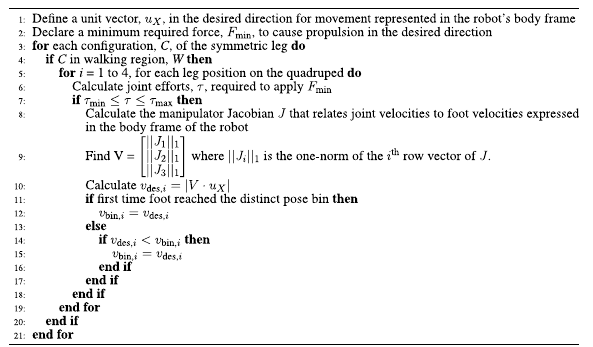
Algorithm 4. Average Desired Velocity Metric